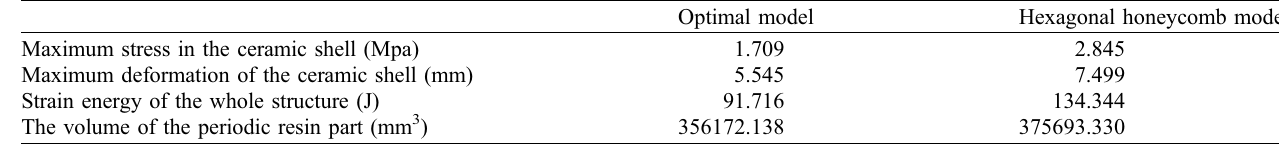
Table 3. Comparison of the optimal model and the hexagonal honeycomb model.